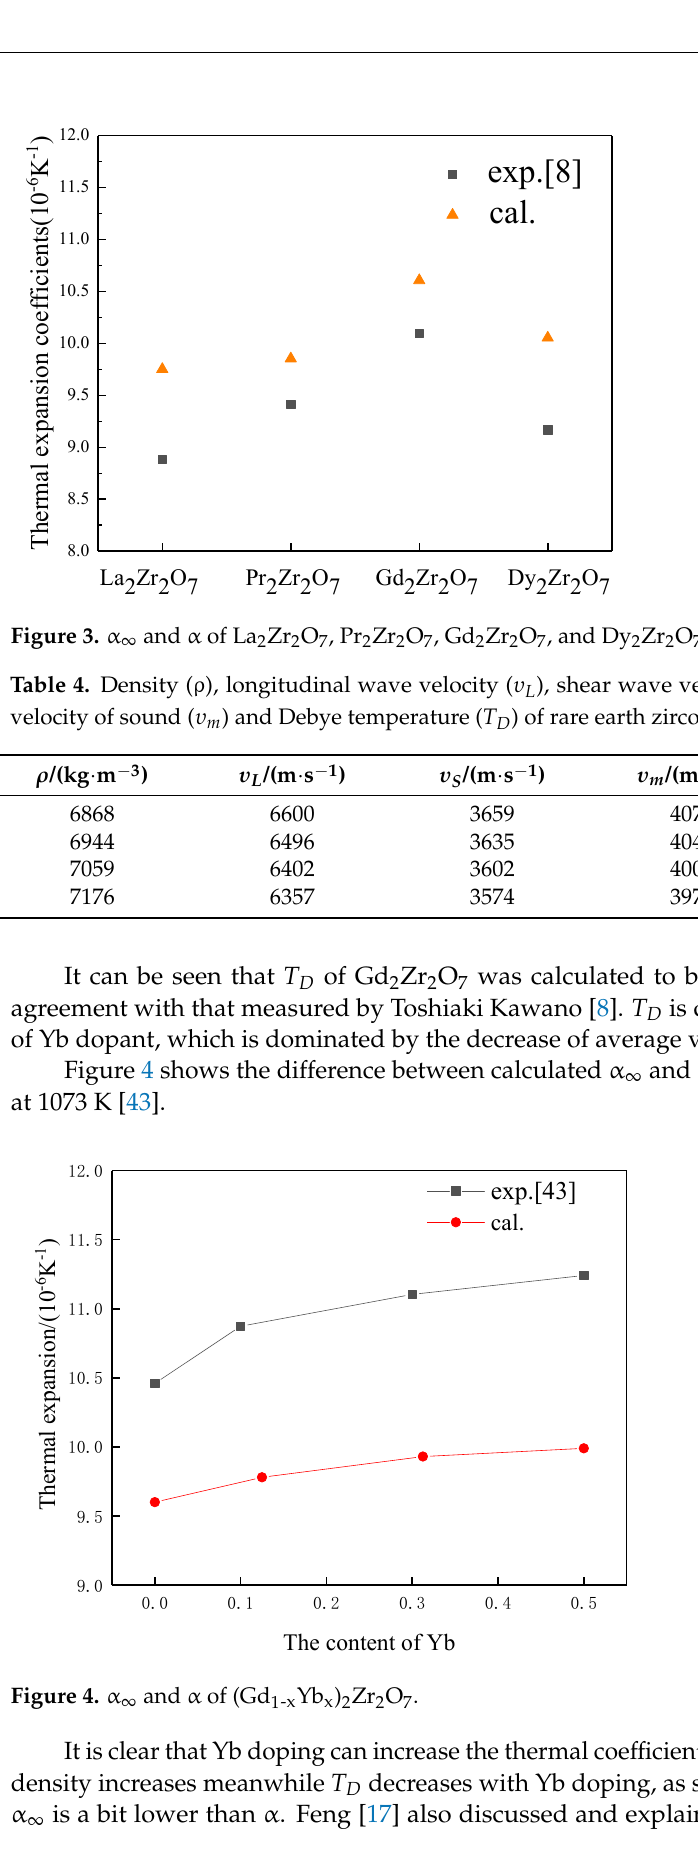
1 -x Yb x ) 2 Zr 2 O 7